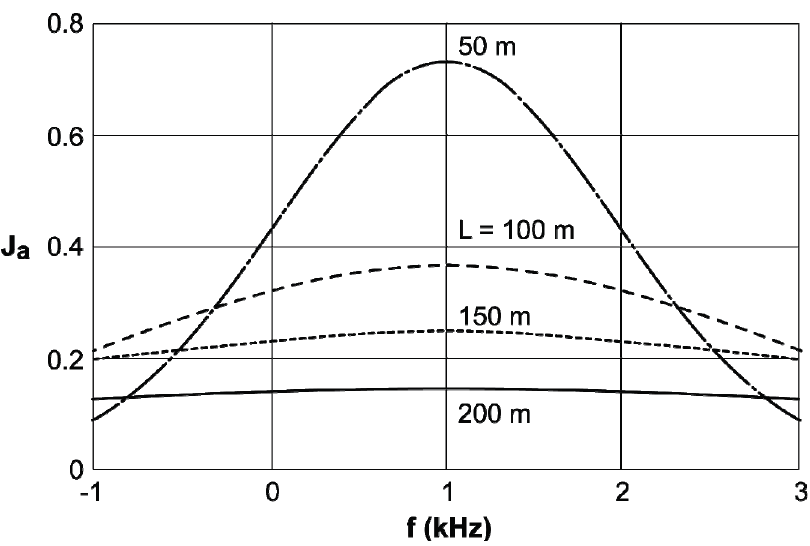
Figure 8. Spectral broadening by turbulence increasing with distance of